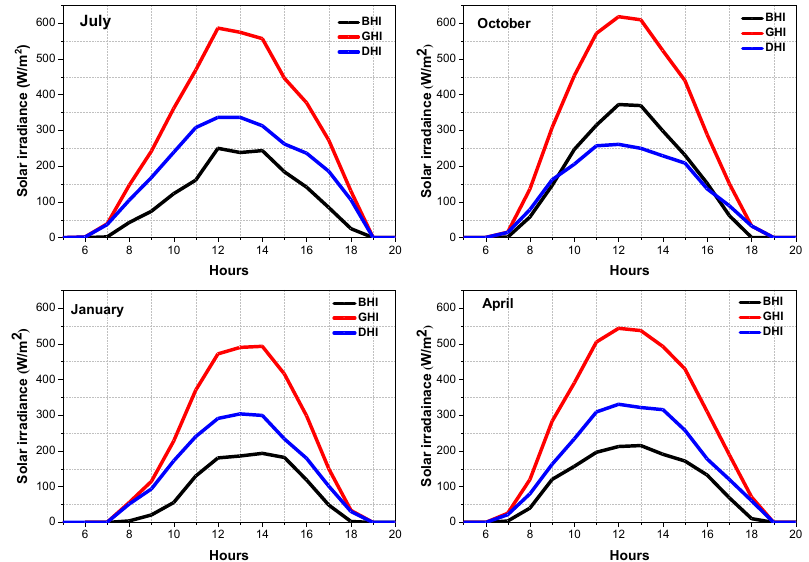
Figure 5. Monthly average hourly solar radiation for July, October, January and April.